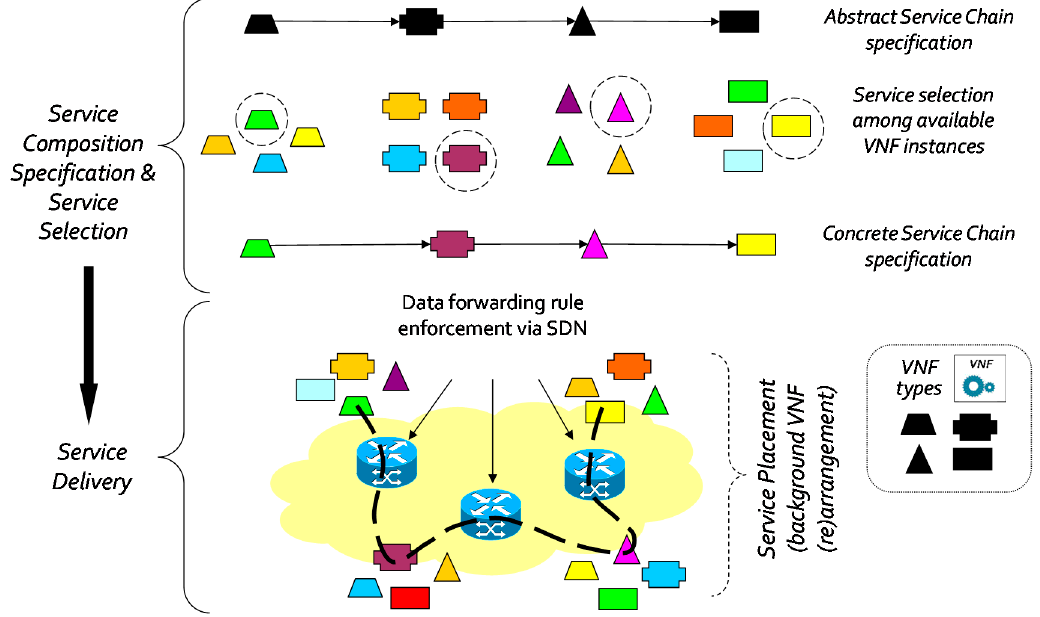
Figure 3. Service ‐ oriented mechanisms for dynamic service chaining of Virtual Network Functions